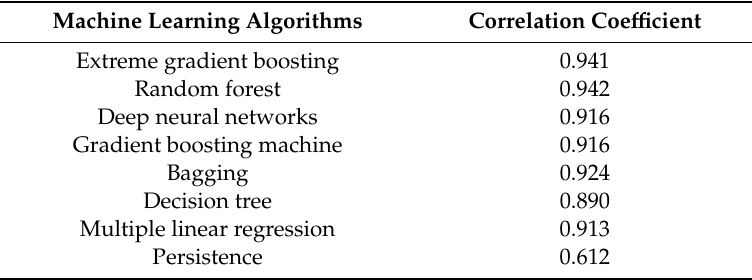
Table 8. Comparison of the Pearson correlation coefficients.